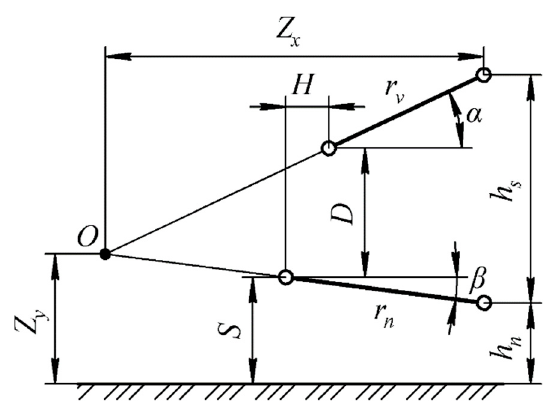
Figure 3. Kinematic diagram of the rear attachment mechanism of the tractor. Table 1. Formulas for determining the parameters of the rear attachment of the tractor (Figure 3). Angle Calculation